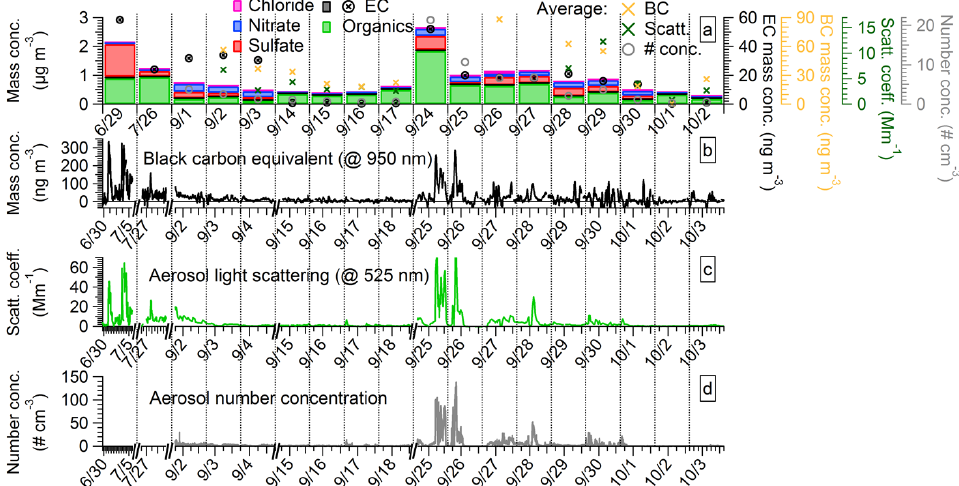
Figure 1. Time series of filter-collected aerosol species during the 2012 field campaign (a) . The name of each filter measurement labeled on the x axis is defined as the start date of measurement. Also shown are the time series of the collocated black carbon (b) , aerosol light scattering (c) , and particle number concentration measurements (d) for the periods overlapping with filter collection. On-line measurements are shown for all overlapping periods and each filter-collection period in (a) matches the continuous measurements in (b–d) . Black dashed lines denote the start and end times of filter sampling. The on-line aerosol measurements were averaged for the filter-sampling periods and are represented by symbols in (a) ; these averages represent a simultaneous comparison with filter-collected